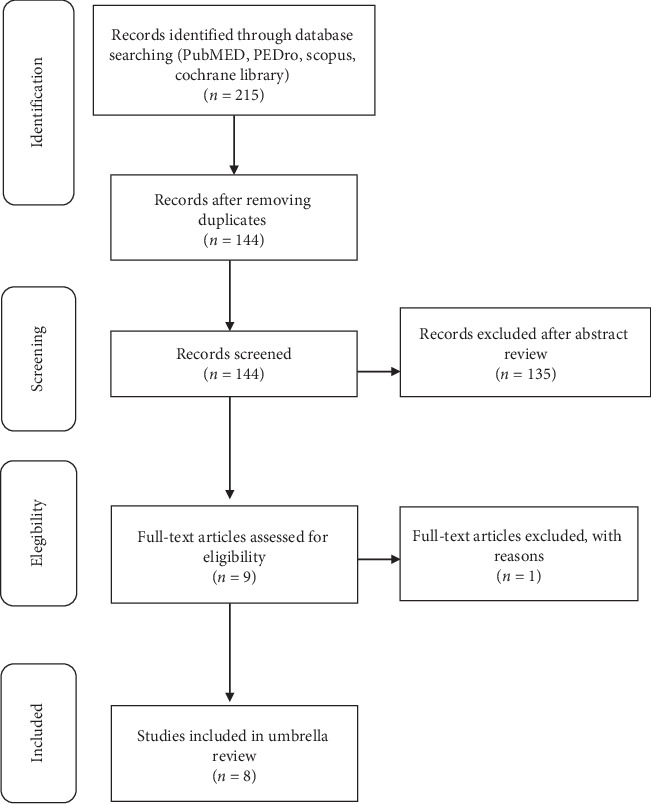
Flowchart of the included studies.